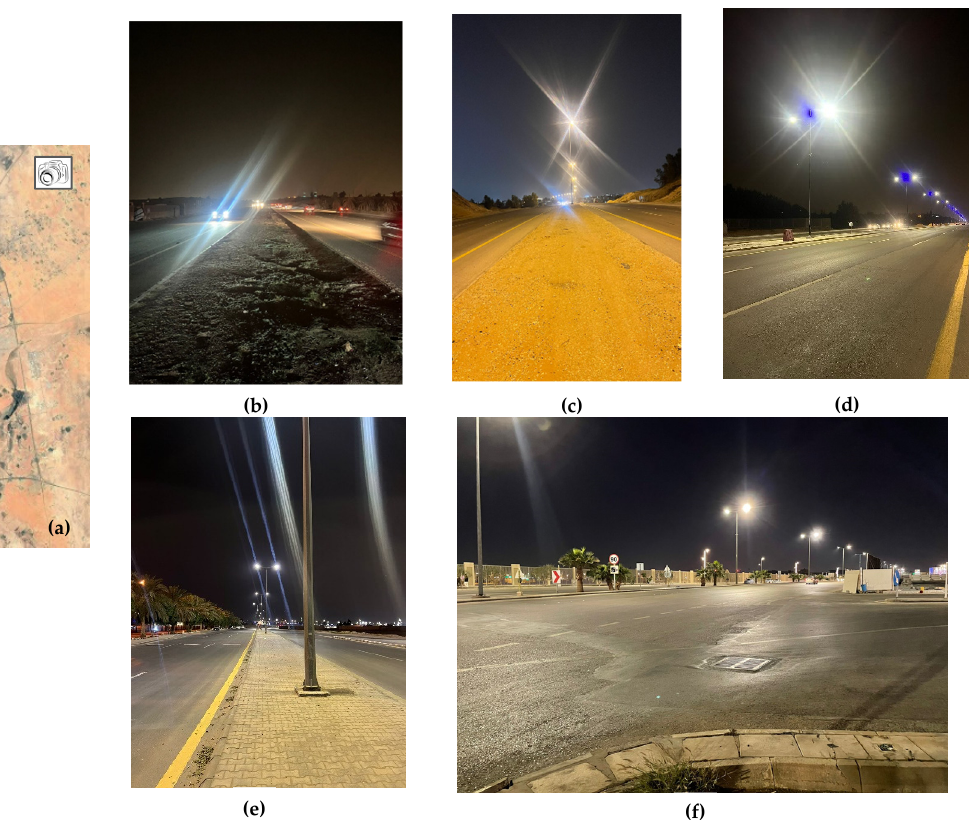
Figure 2. The urban street-lighting system in the study area and vignettes of urban street-lighting, ( a ) road network map, ( b ) road section without street-lighting—high beams are common, ( c ) road section with appropriate lighting intensity, ( d ) road lighting with additional blue fancy lights, ( e ) ap- propriate lighting on the urban highway, and ( f ) over-lit pavement may cause glare to eyes of road